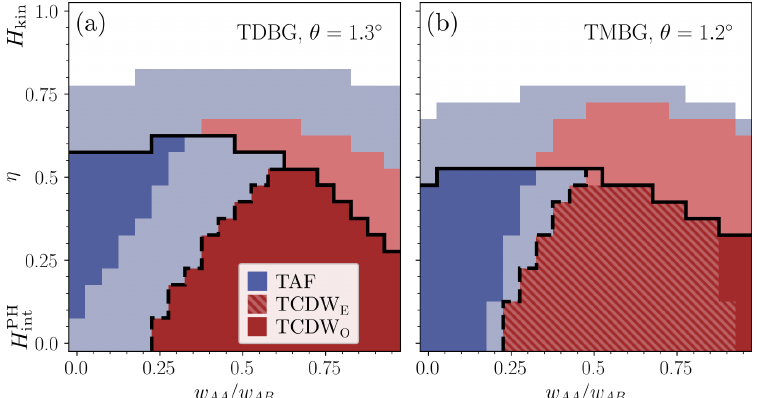
Figure 8: Phase diagram at ν “ 7 { 2 with particle-hole symmetric interactions. Except for the lack of stabilization of the nematic TCDW as the absolute ground state for (a) TDBG as well as (b) TMBG, the same phases as in Fig. 1 (a) compete in the valley polarized parameter regime. Below the solid black line, signatures of valley polarized TAF or TCDW phases are present in ED while the dashed line indicates the spin phase transition. The magnetic order in light-colored regions manifests only in one of the two